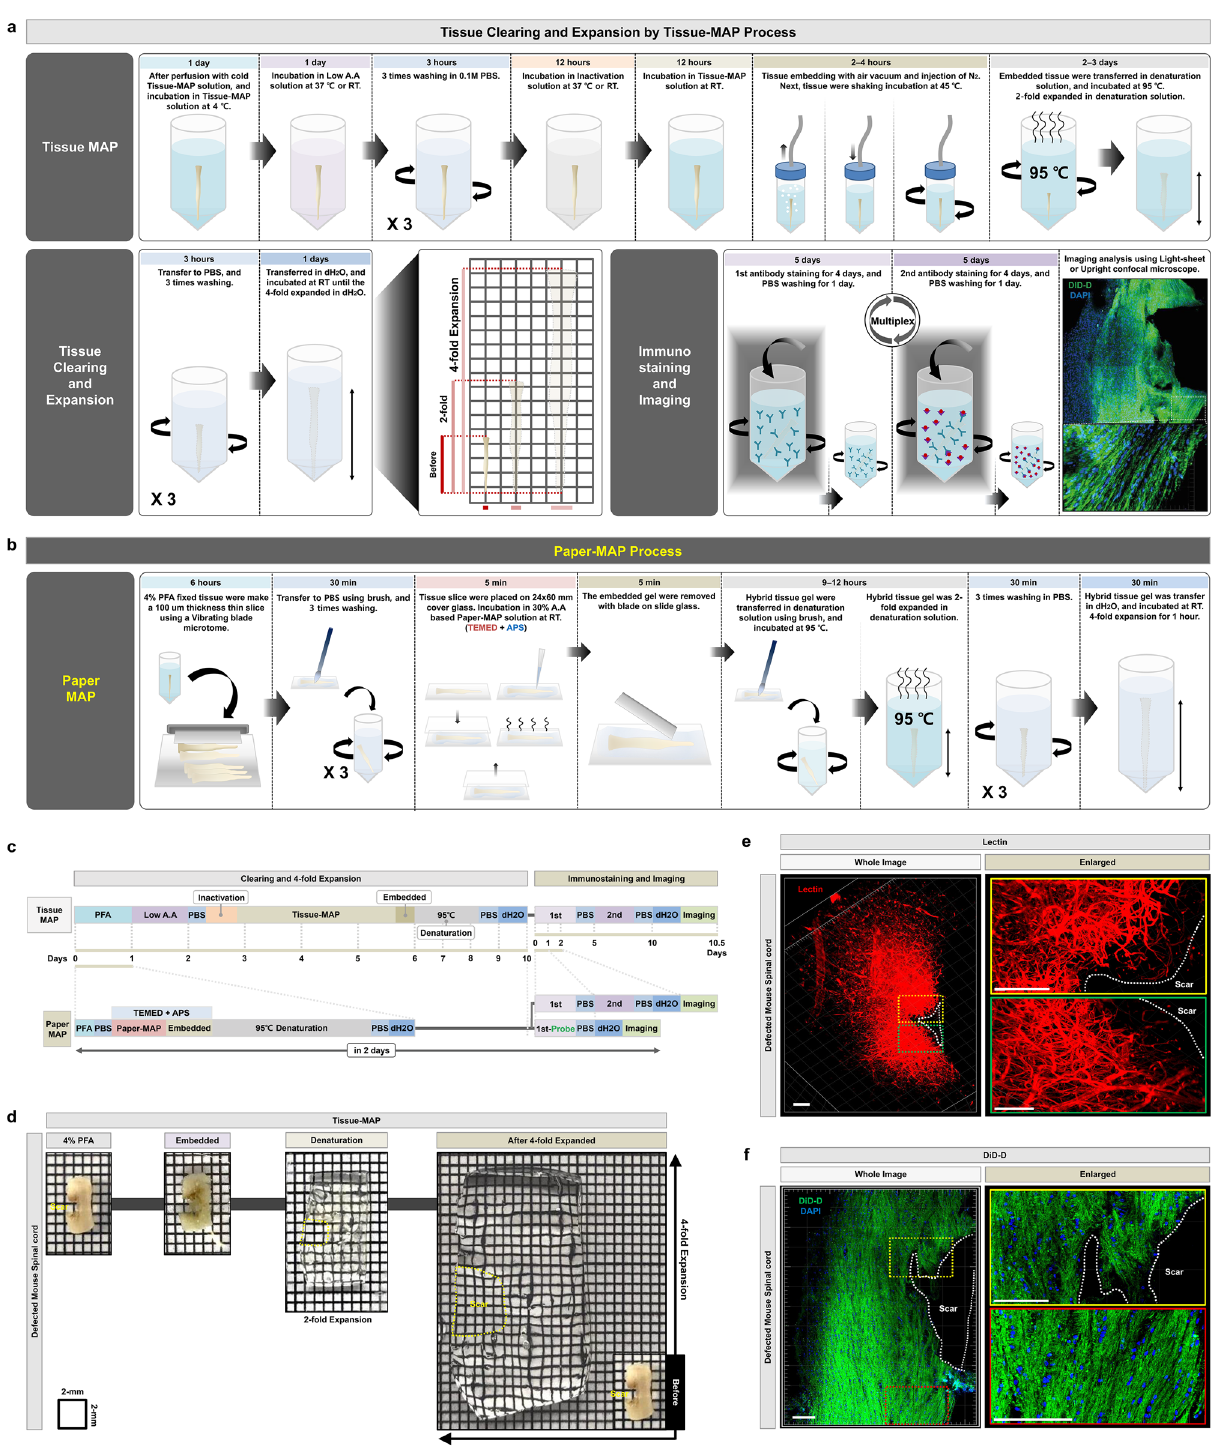
Figure 1. Tissue clearing and expansion via Tissue-MAP. ( a ) Schematic representation of Tissue-MAP protocol for clearing, expanding, and subsequent immunostaining of whole tissue. ( b ) Schematic representation of Paper- MAP processing using 100 μm-thick tissue sections. ( c ) Timeline of Tissue-MAP and Paper-MAP. ( d ) Optical transparency of injured mouse spinal cord achieved via Tissue-MAP. Tissue transparency was assessed against a patterned background (length:width = 5 mm:5 mm). ( e and f ) Three-dimensional rendering of lectin (red) and DiD-D (green) immunostaining of injured mouse spinal cord tissue processed via Tissue-MAP, imaged with light-sheet microscopy (range: 2000-μm) and confocal microscopy (tile-scanned single-z image). Dotted white lines indicate scar region. Scale bar, 100-μm. Illustration of mechanism is visualized by PowerPoint